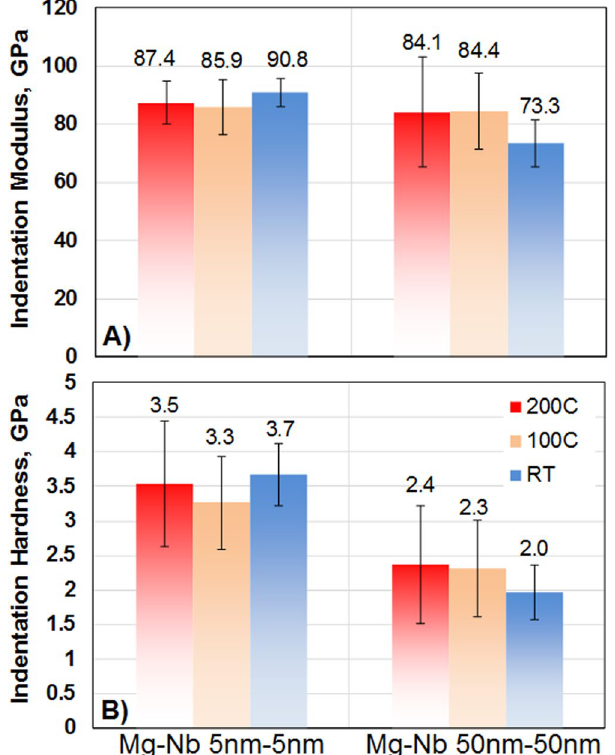
Figure 4. ( a ) Indentation modulus and ( b ) hardness (average ± standard deviation) of 5 nm/5 nm